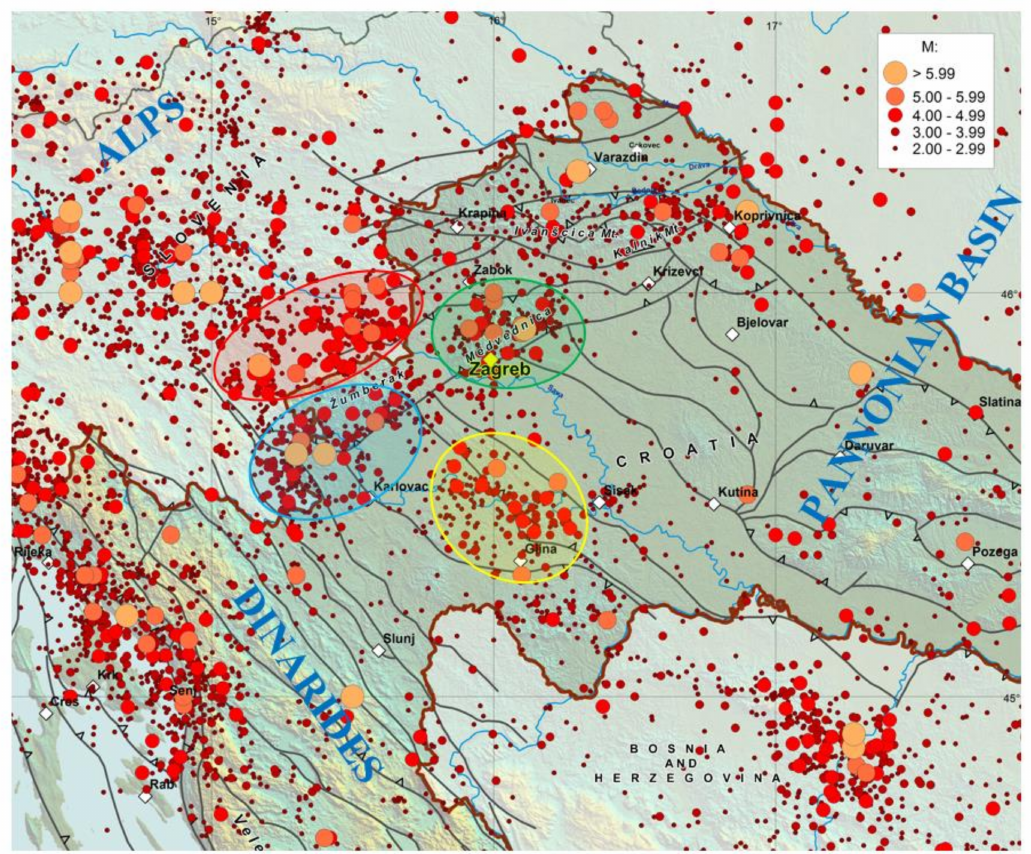
Figure 2. Spatial distribution of earthquake locations in the investigated area (373BC–2019, according to the Croatian Earthquake Catalogue-CEC, the updated version first described in [27]. Seismic zones are markedas: Zagreb-green, NovoMesto-Krško-red, Karlovac-Metlika-blueandPokupsko-Petrinja-yellow. Faults are marked with black lines